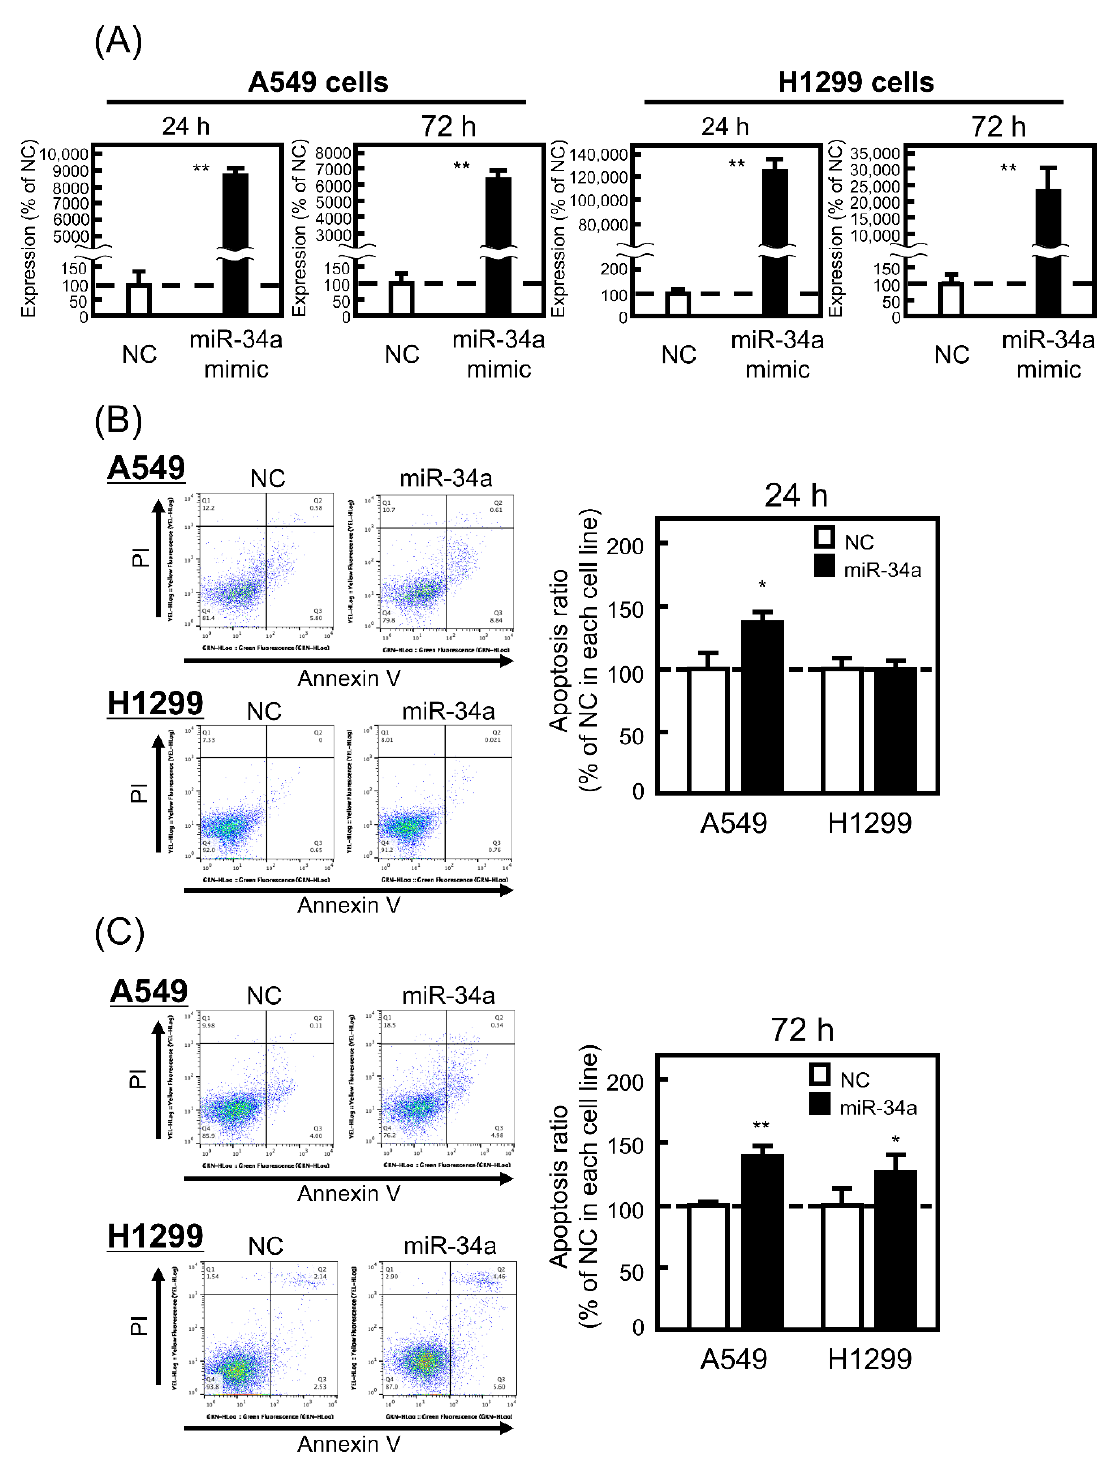
Figure 1. Effect of microRNA (miR)-34a overexpression on the apoptosis of A549 and H1299 cells. These cells were transfected with the negative control (NC; 20 pmol/well) or miR-34a mimic (20 pmol/well) for 24 h. After 24 or 72 h, ( A ) miR-34a expression levels were measured by real-time polymerase chain reaction (PCR) and ( B , C ) the ratio of apoptotic cells (annexin V-positive, propidium iodide (PI)-negative) was detected and analyzed by flow cytometry as described in Section 2. Each value represents the mean ± standard error of the mean (S.E.M). (n = 3). * p < 0.05, ** p < 0.01, significantly different from